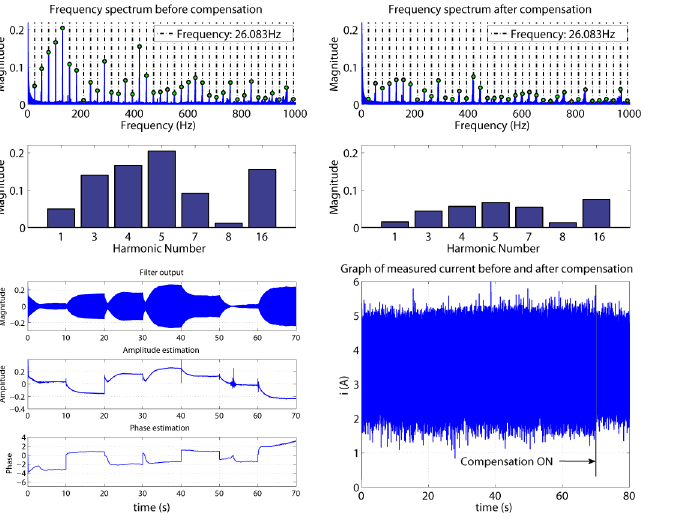
Fig 15. Compensation of a 7V excitation signal with no load.